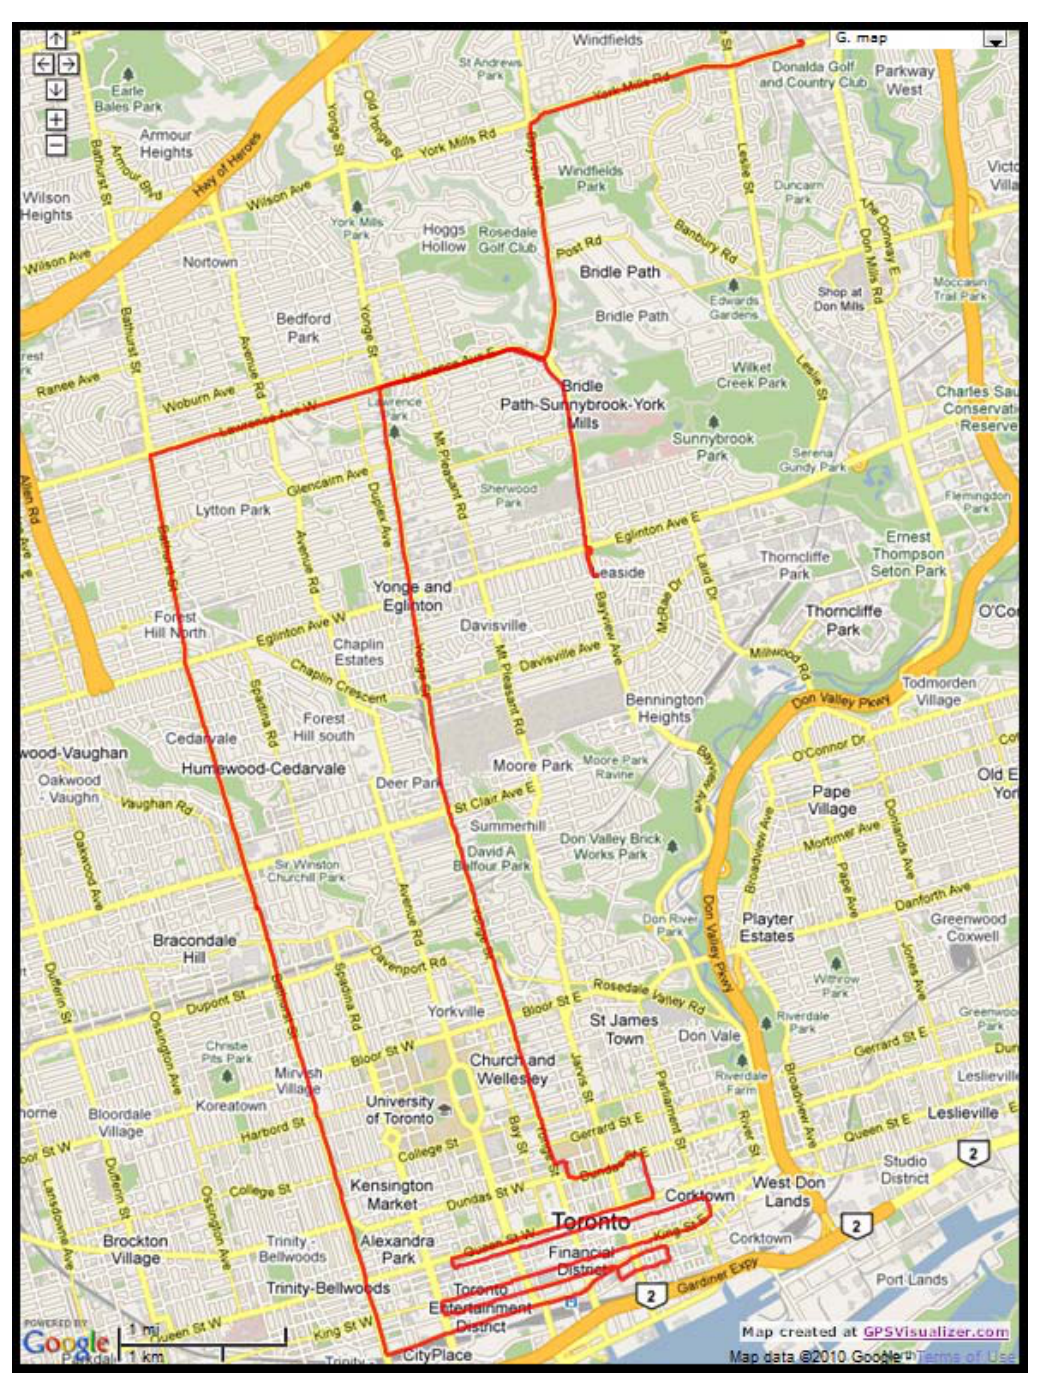
Figure 17. Road test trajectory in